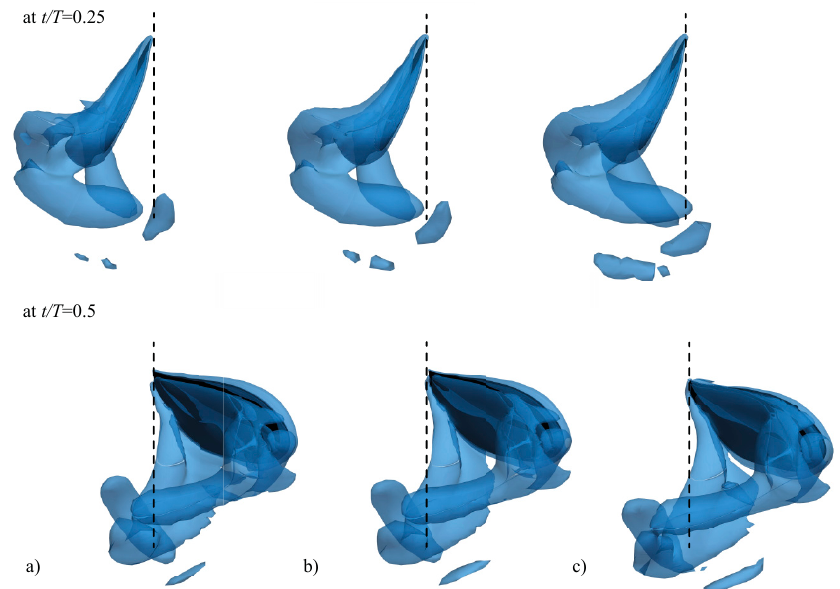
Figure 9 . Contour plots of the NSe iso-surfaces of Q -criterion at Q = 0.75 at t/T = 0.25 ( top ) and t/T = 0.5 ( bottom ) for motions with pitching duration, ( a ) Δ τ r = 0.2, ( b ) Δ τ r = 0.3, and ( c ) Δ τ r = 0.5; Mild motions with A = 30° and x pa = 0.5.